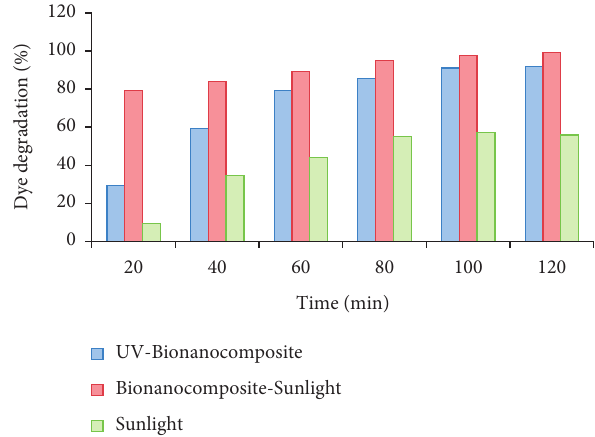
Figure 14: Photocatalytic activity of the MgO NPs expressed as percentage of methylene blue dye